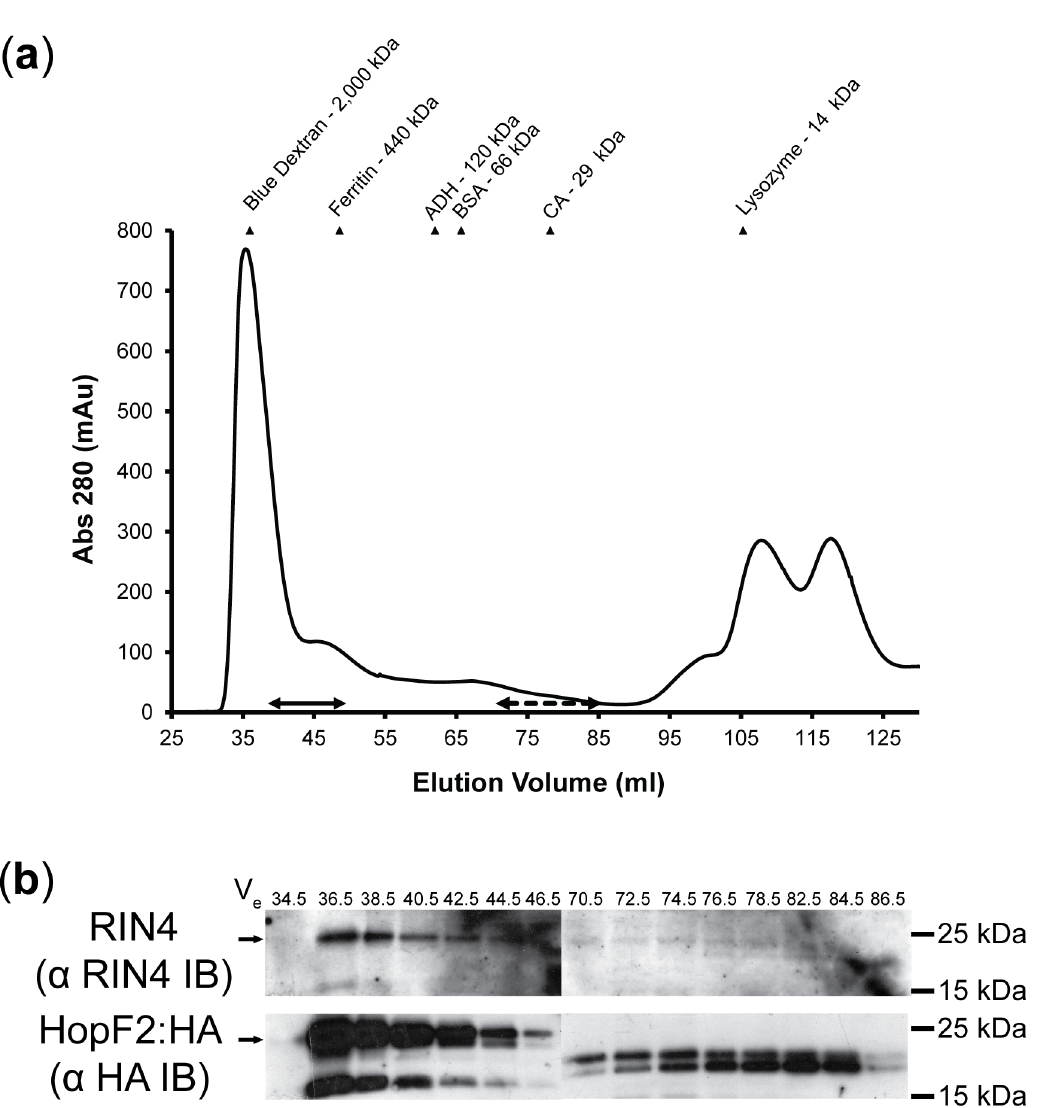
Fig. 1. Identification of HopF2/RIN4 complexes by gel filtration chromatography and immunoblotting. Clarified extracts from HopF2:HA overexpressing plants were subjected to gel filtration chromatography on a Sephacryl S-300 HR 16/60 column. Every second fraction from the void volume was resolved by SDS-PAGE and immunoblotted with anti RIN4 immunosera and anti-HA IgG. Bands were visualized with HRP-conjugated secondary anti- bodies and Amersham ECL Advance detection kit. (a) Elution profile of dexamethasone treated Arabidopsis HopF2:HA clarified extract fractionated by gel filtration chromatography. Solid Arrow indicates elution of HA and RIN4 immunoreactive bands. Dashed arrow indicates elution of HA immunoreactive bands alone. Elution volumes of six molecular weight standards are shown as triangles. (b) Immunoblots (IB) showing co-elution of RIN4 and HA immunoreactive bands at high molecular weight. Results are representative of 3 independent replicates. Arrows indicate expected band size for RIN4 (25 kDa) and HopF2 (25 kDa),